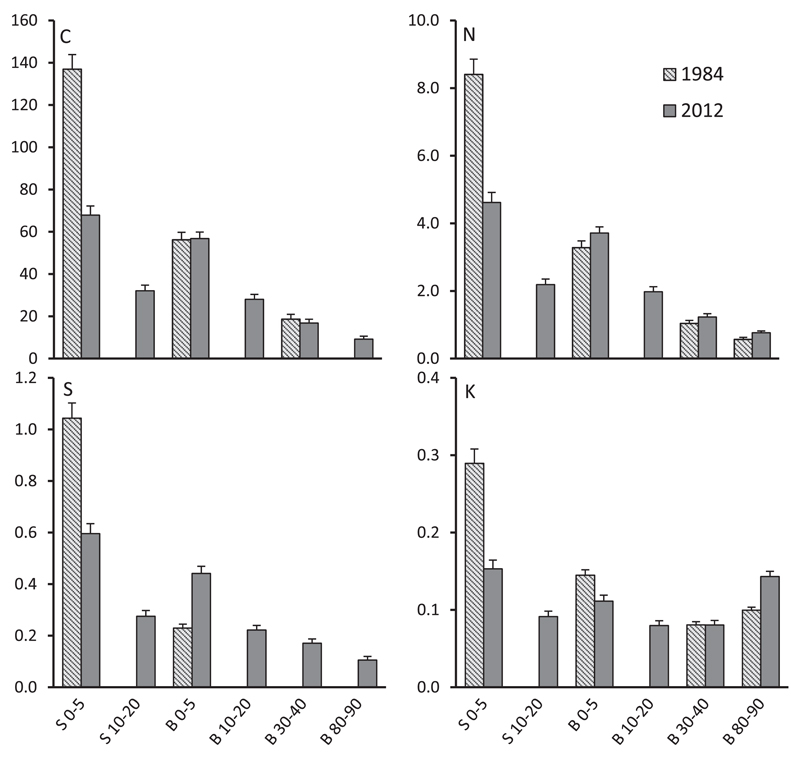
Mean soil contents of Corg, Ntot, Stot and Kexch content (mg g−1) in different soil depths of the stemflow area (S 0–5 and S 10–20) and the between trees area (B 0–5, B 10–20, B 30–40 and B 80–90) at 97 beech stands in 1984 and 2012. Error bars are ± S.E.